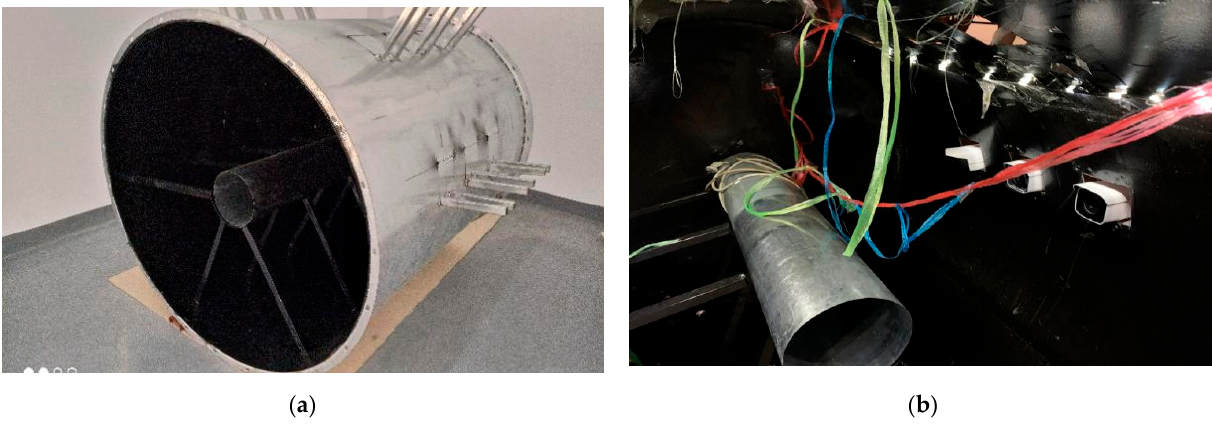
Figure 8. Data collection scene used for SAES: ( a ) Simulated aero engine chamber, which contains multiple camera positions, a simulated aero engine bracket, and a simulated aero engine; and ( b ) shows the site layout for collecting video data. In addition, LED point light sources and colorful analog cables are arranged in the chamber, in order to simulate the real scene.